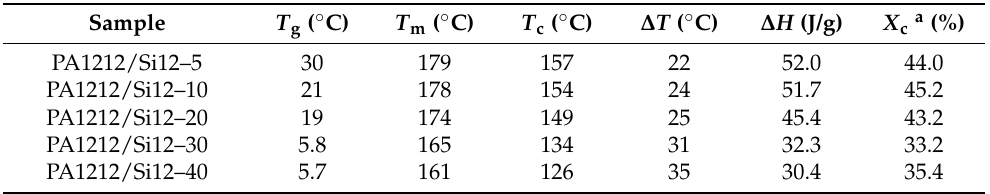
Table 2. The thermal transition parameters of PA1212/Si12